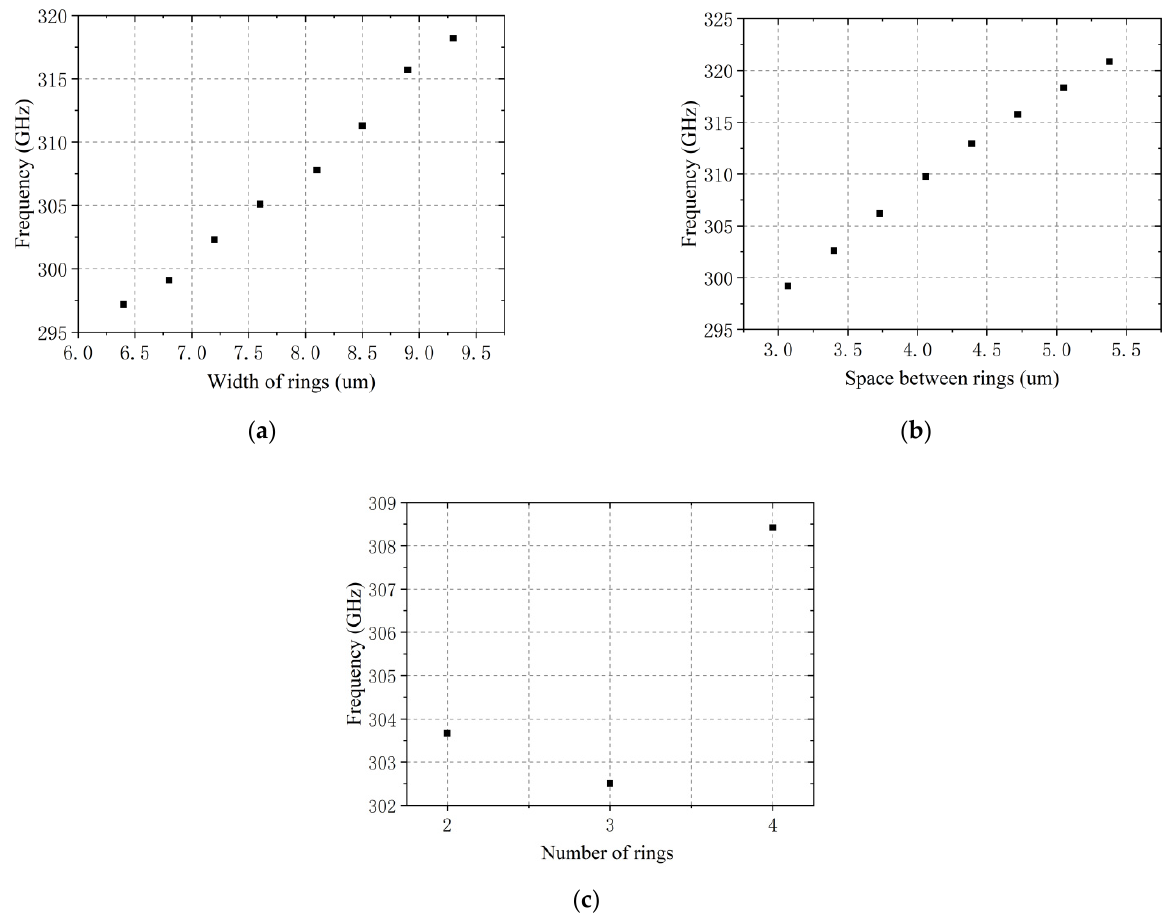
Figure 4. Effect of antenna parameters on resonance frequency: ( a ) width of rings; ( b ) space between rings; ( c ) number of rings.